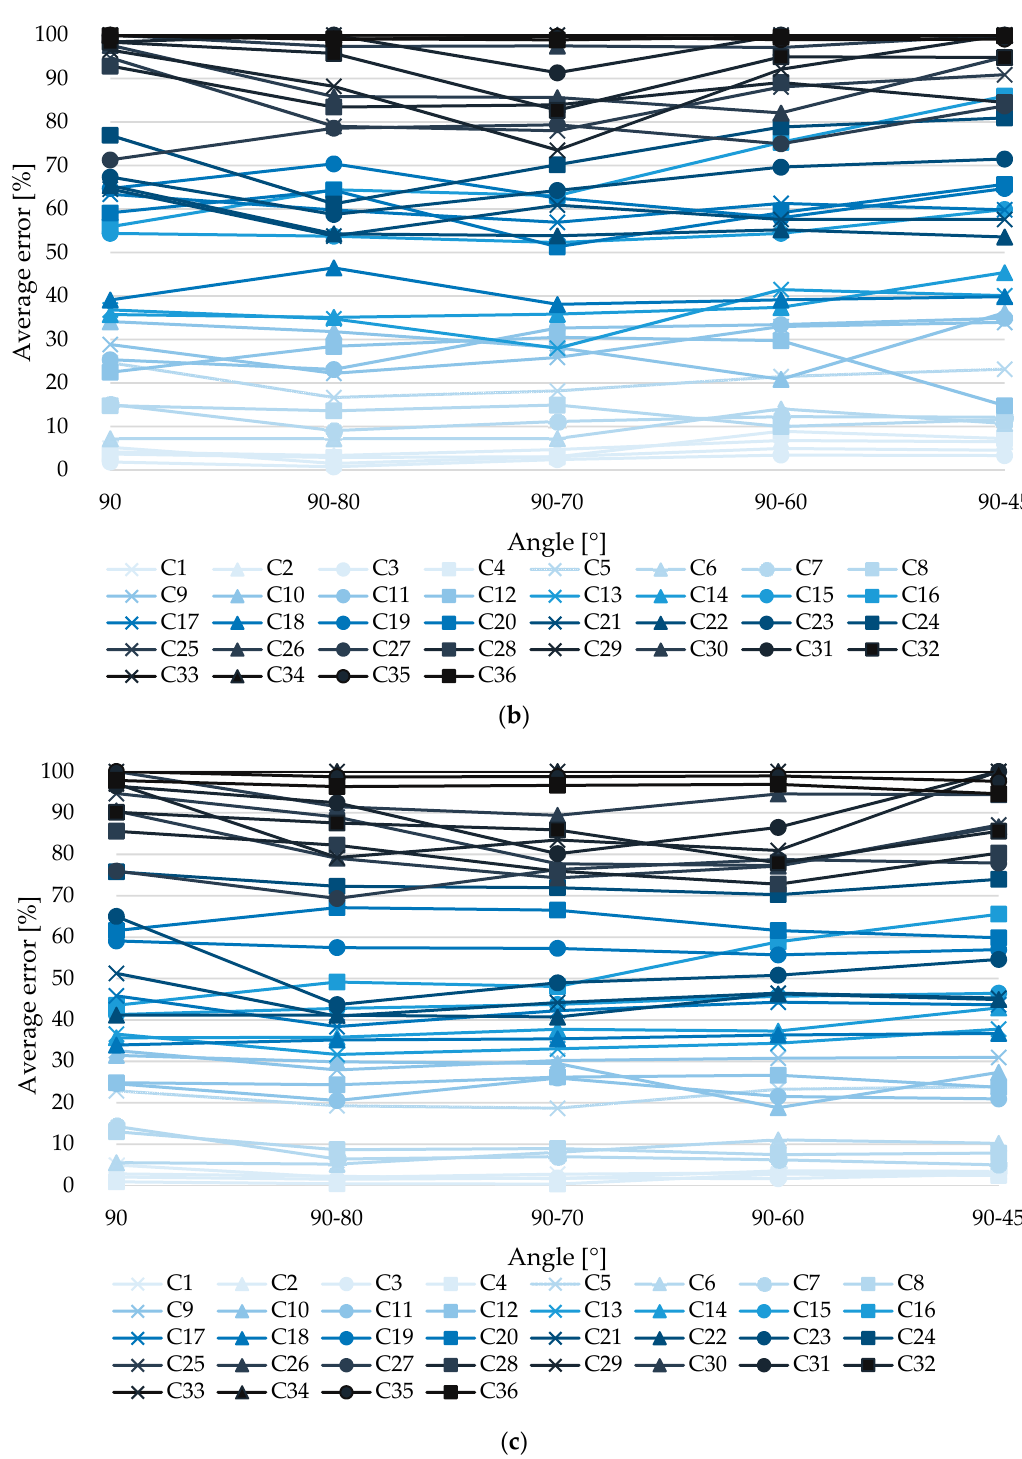
Figure 7. Average relative error behavior of volume for different severity levels. ( a ) low severity; ( b ) mean severity; ( c ) high severity.